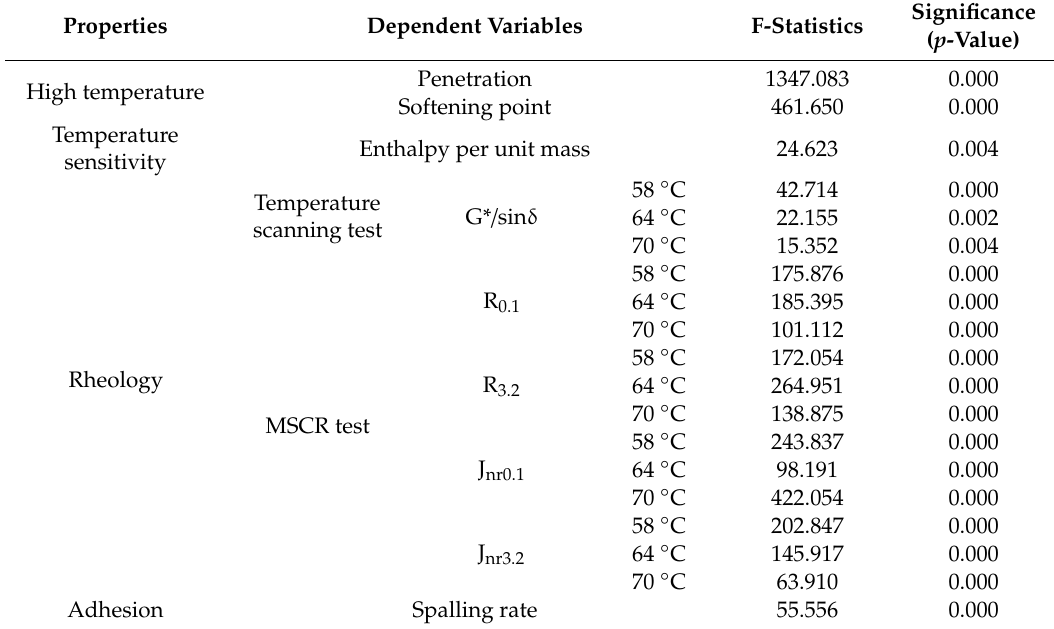
Table 6. ANOVA results of the e ff ect of WER content on the WESAE residue